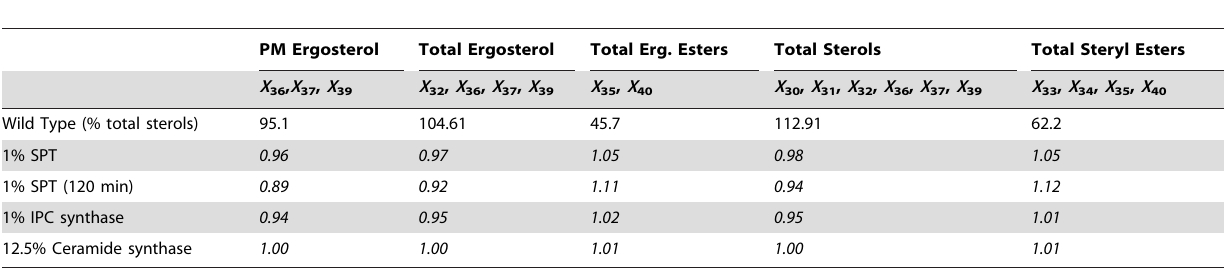
Table 2. Steady-state values of PM ergosterol, total ergosterol, total ergosterol-esters, total sterols, and total steryl-esters in the SL- E model under different experimental conditions, after 60 minutes.